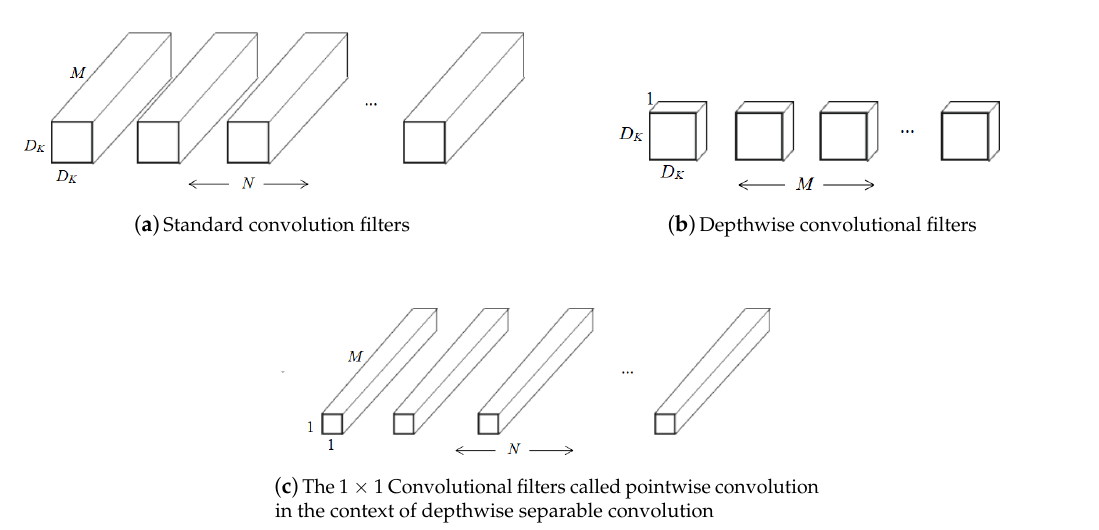
Figure 6. Structure of standard convolution filters and depthwise convolutional